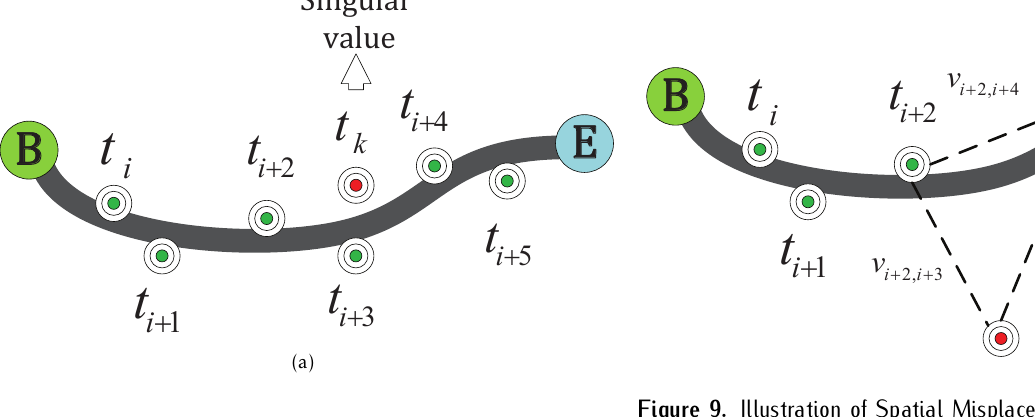
Figure 9. Illustration of Spatial Misplace. t has a deflection i +3 from the main road, which can be tested by communication error between GPS devices and GPS servers. The average speed is calculated for finding the deflection points. In the figure, v i +2 ,i +3 is the average speed between t and t , and so are v i +2 i +3 i +3 ,i +4 and v . By comparison, v and v are much i +2 ,i +4 i +2 ,i +3 i +3 ,i +4 more larger than v . Frequently their values exceeds taxis’ i +2 ,i +4 maximum speed. So we can consider t as an invalid point and i +3 remove it from logs. In the end, some taxis have only a small number of records, so they are not suitable for the Figure 8. Illustration of Temporal Disorder. In Figure 8(a), on the road segment from B to E , there are several points among t and i t i +5 , and t k ’s temporal tag doesn’t match the surrounding points’ tags, which makes it a broken point. So t should be removed k in the pre-precessing stage. In Figure 8(b), t shifts ahead t 3 2 (or t shifts behind t ). Two solutions are used for solving this 2 3 temporal error. One is removing t or t , the other is correcting 2 3 t 2 ’s or t 3 ’s temporal tag. Both solutions need the average speed parameter as a reference.